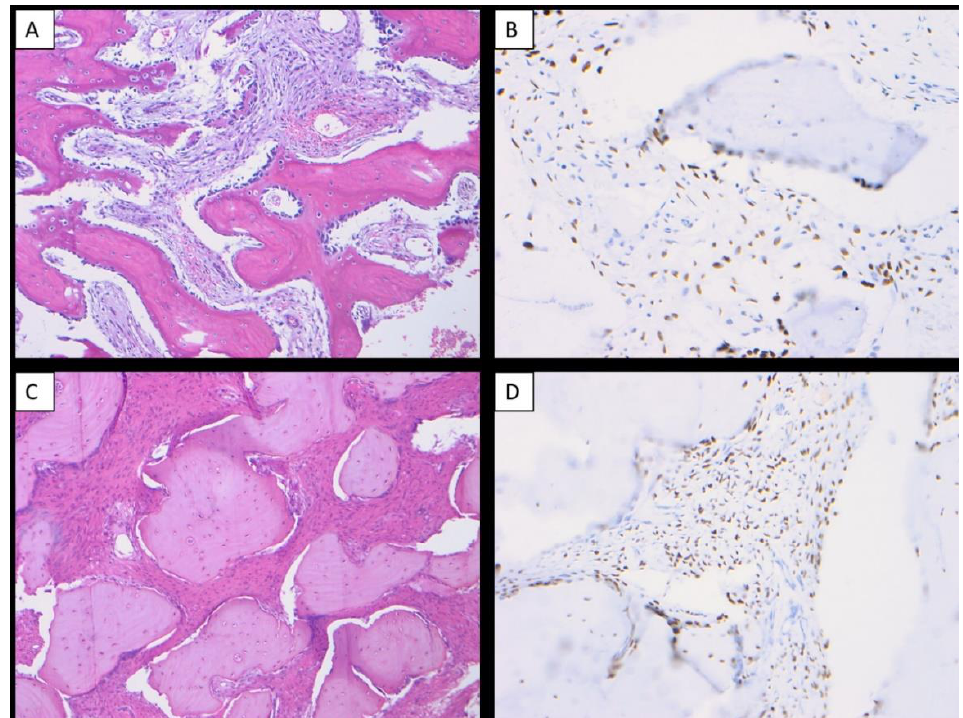
Figure 2. Benign fibro-osseous lesions of the jaw were immunoreactive to SATB2. Ossifying fibroma of the jaw (H & E ×100) ( A ), ossifying fibroma demonstrating nuclear immunoreactivity with strong intensity and diffuse staining pattern to SATB2 in the stromal plump and spindle cells (×200) ( B ), fibrous dysplasia of the jaw (H & E ×100) ( C ), fibrous dysplasia demonstrating nuclear immunoreactivity with strong intensity and diffuse staining pattern to SATB2 in the stromal plump and spindle cells (×200) ( D ).